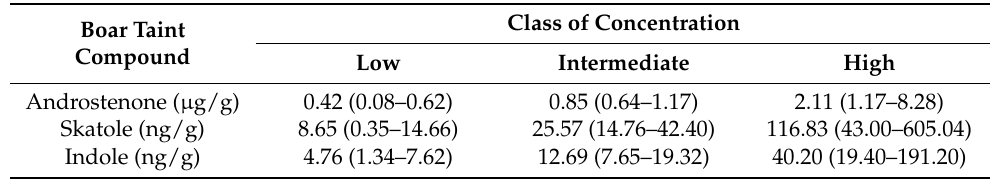
Table 1. Mean (range) concentration of boar taint compounds in each class of concentration (low— below the 33rd percentile of the distribution; intermediate—between the 33rd and 67th percentile, high—above the 67th